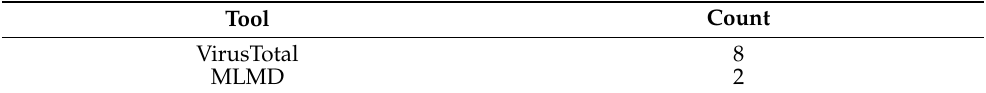
Table 19. Number of samples classified incorrectly to be malicious samples.